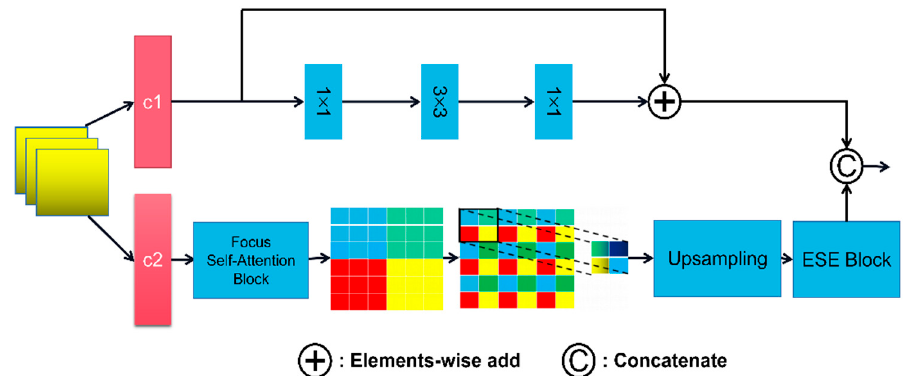
Figure 4. An illustration of the structure of CSPFSA Block. In the figure, the structure of CSPNet is still used to enrich the gradient information and reduce the amount of computation, where the upper part is the original structure of a common residual block, the features of the lower part perform the calculation of self-attention and channel attention.